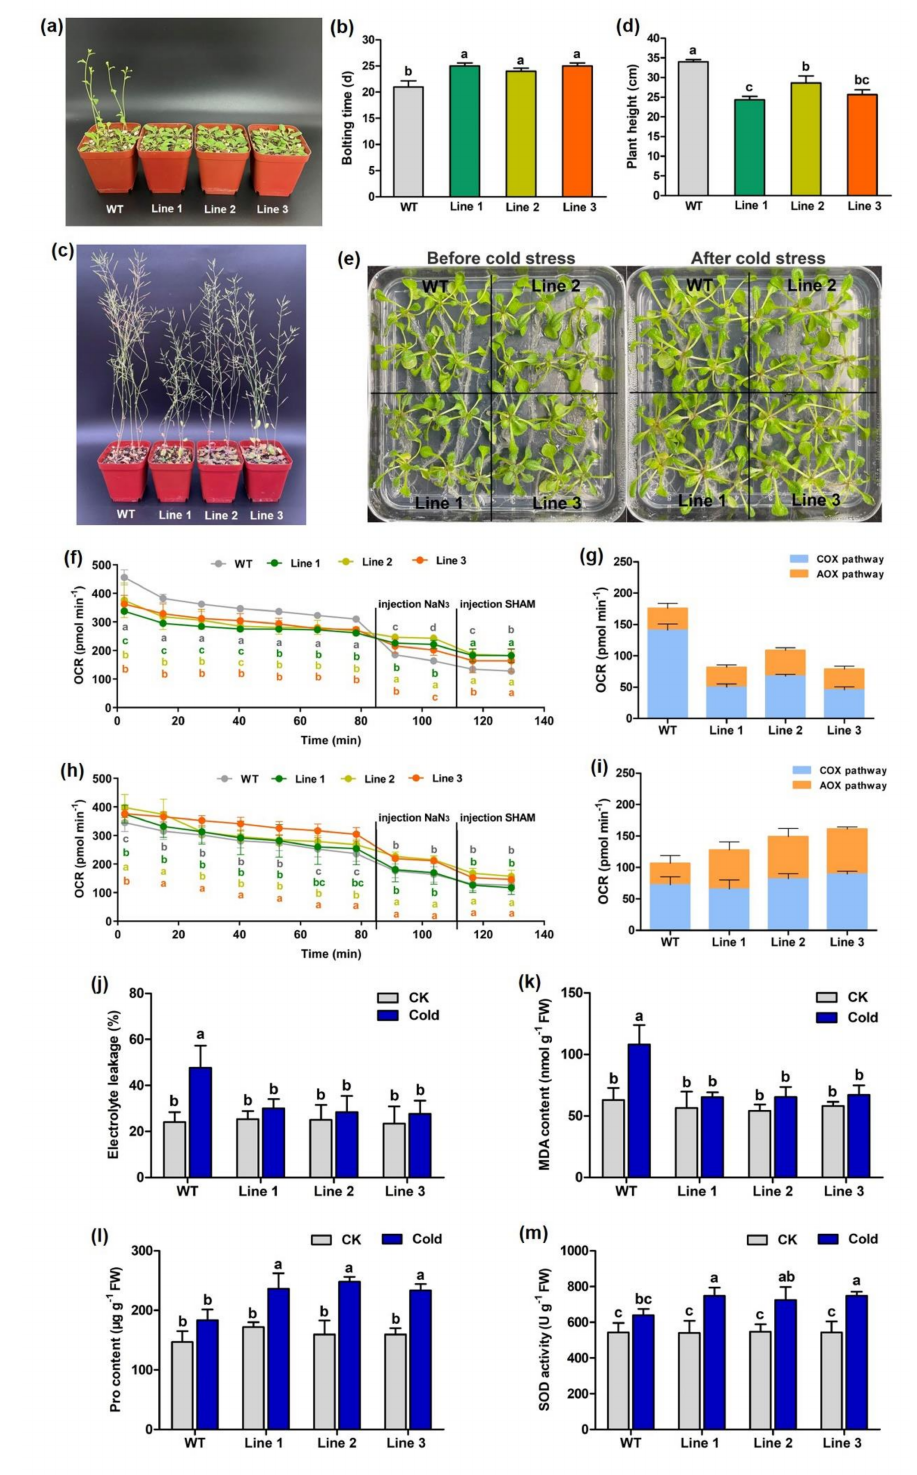
Figure 7. Phenotypes and cold resistance analysis of WT and PeAOX1b transgenic Arabidopsis. ( a ) WT and transgenic Arabidopsis cultured for 23 days. ( b ) Bolting time of WT and transgenic Arabidopsis. ( c ) WT and transgenic Arabidopsis cultured for 40 days. ( d ) Plant height of WT and